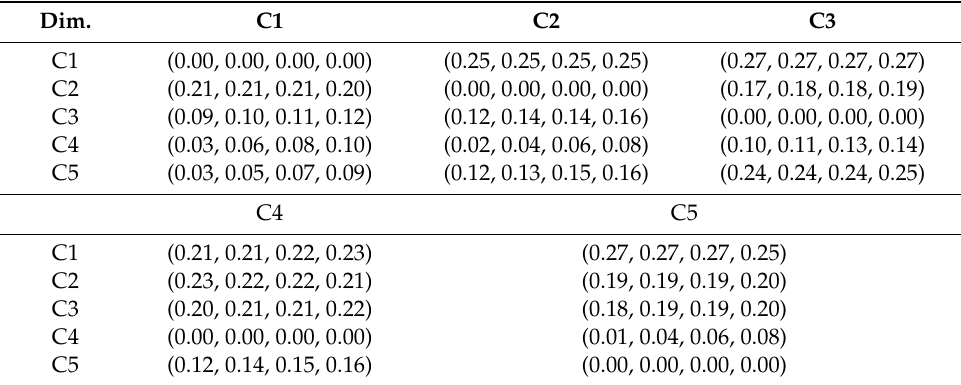
Table 6. Normalized fuzzy direct-relation matrix.